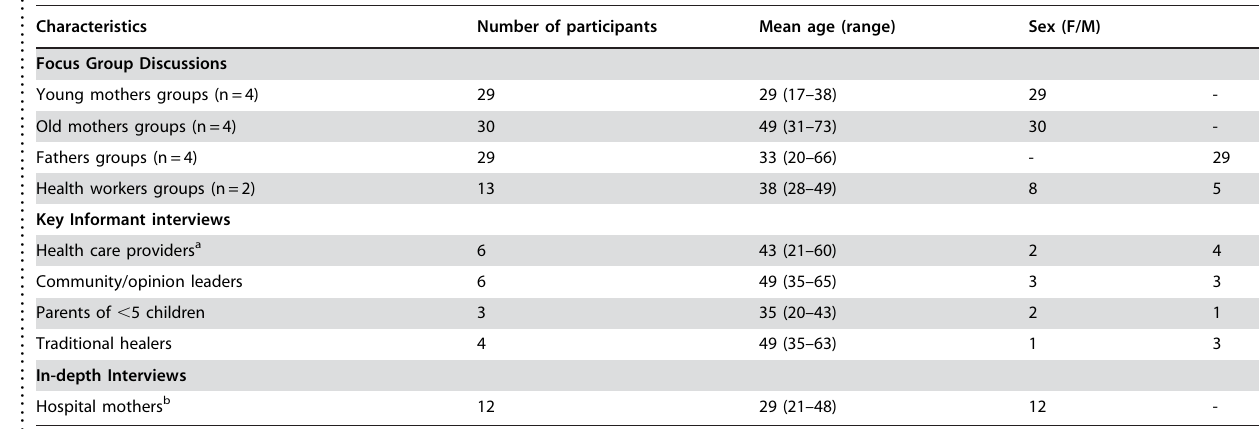
Table 1. Sociodemographic profile of the study participants. .. ... .... ... ... .... ... ... .... ... ... .... ... ... .... ... ... .... ... ... .... ... ... .... ... ... .... ... ... .... ... ... .... ... ... .... ... ... .... ... ... .... ... ... .